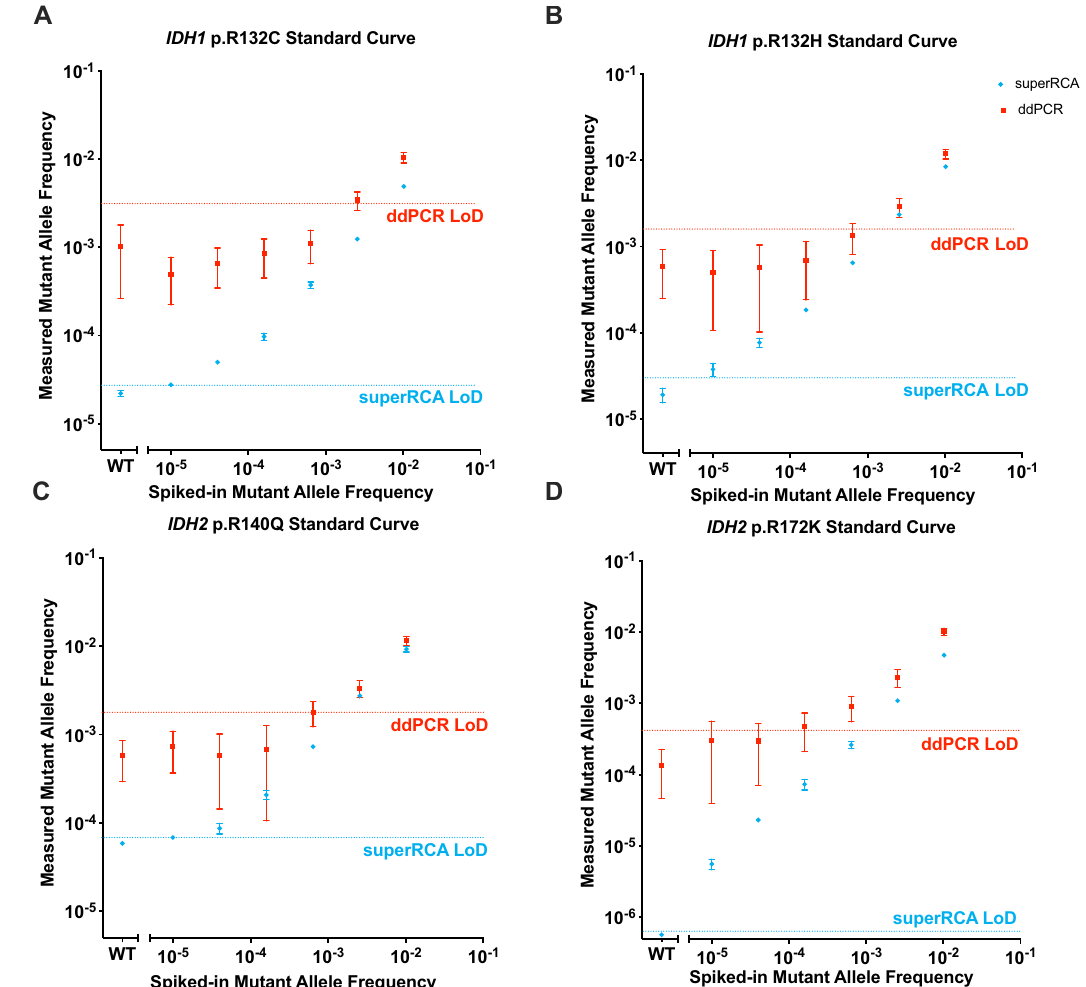
Fig. 4 Comparison between analytical performance of superRCA and ddPCR assays for four IDH mutations. Analysis of four-fold serial dilutions of genomic DNA from cells with A IDH1 p.R132C, B IDH1 p.R132H ( C ) IDH2 p.R140Q, and D IDH2 p.R172K mutations using the superRCA procedure or ddPCR. Genomic DNA samples with mutant genomic DNA were serially diluted in wildtype genomic DNA and divided into two portions each for and analysis by superRCA or ddPCR. 330 ng DNA, corresponding to 100,000 human haploid genomes (or a little less than 50,000 cells, considering that the cells are cycling and may have partly replicated their genomes), were analyzed per sample for the superRCA assay, while a total of 100 ng DNA divided in two replicate reactions, corresponding to 15,100 human haploid genomes (corresponding to 7,500 diploid cells) were used for ddPCR, according to the manufacturer ’ s instructions. n = 3 biological replicates were analyzed for superRCA and n = 2 biological replicates were analyzed for ddPCR assay set. The data are presented as mean value ± SD. The limit of detection (LoD) for ddPCR and superRCA assay for each analyte was calculated as LoD = Mean(wildtype) + 3 × SD(wildtype) and presented in the fi gures with horizontal dashed